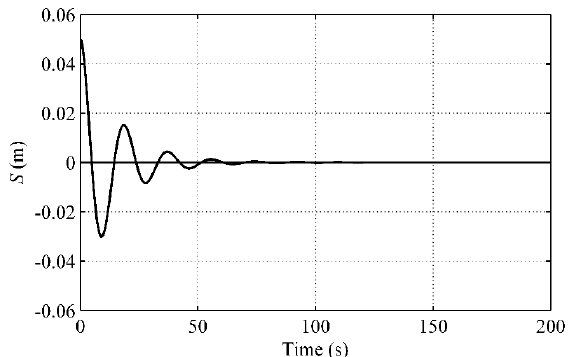
Figure 7. The time series of the horizontal displacement of the mass center of the floating box.